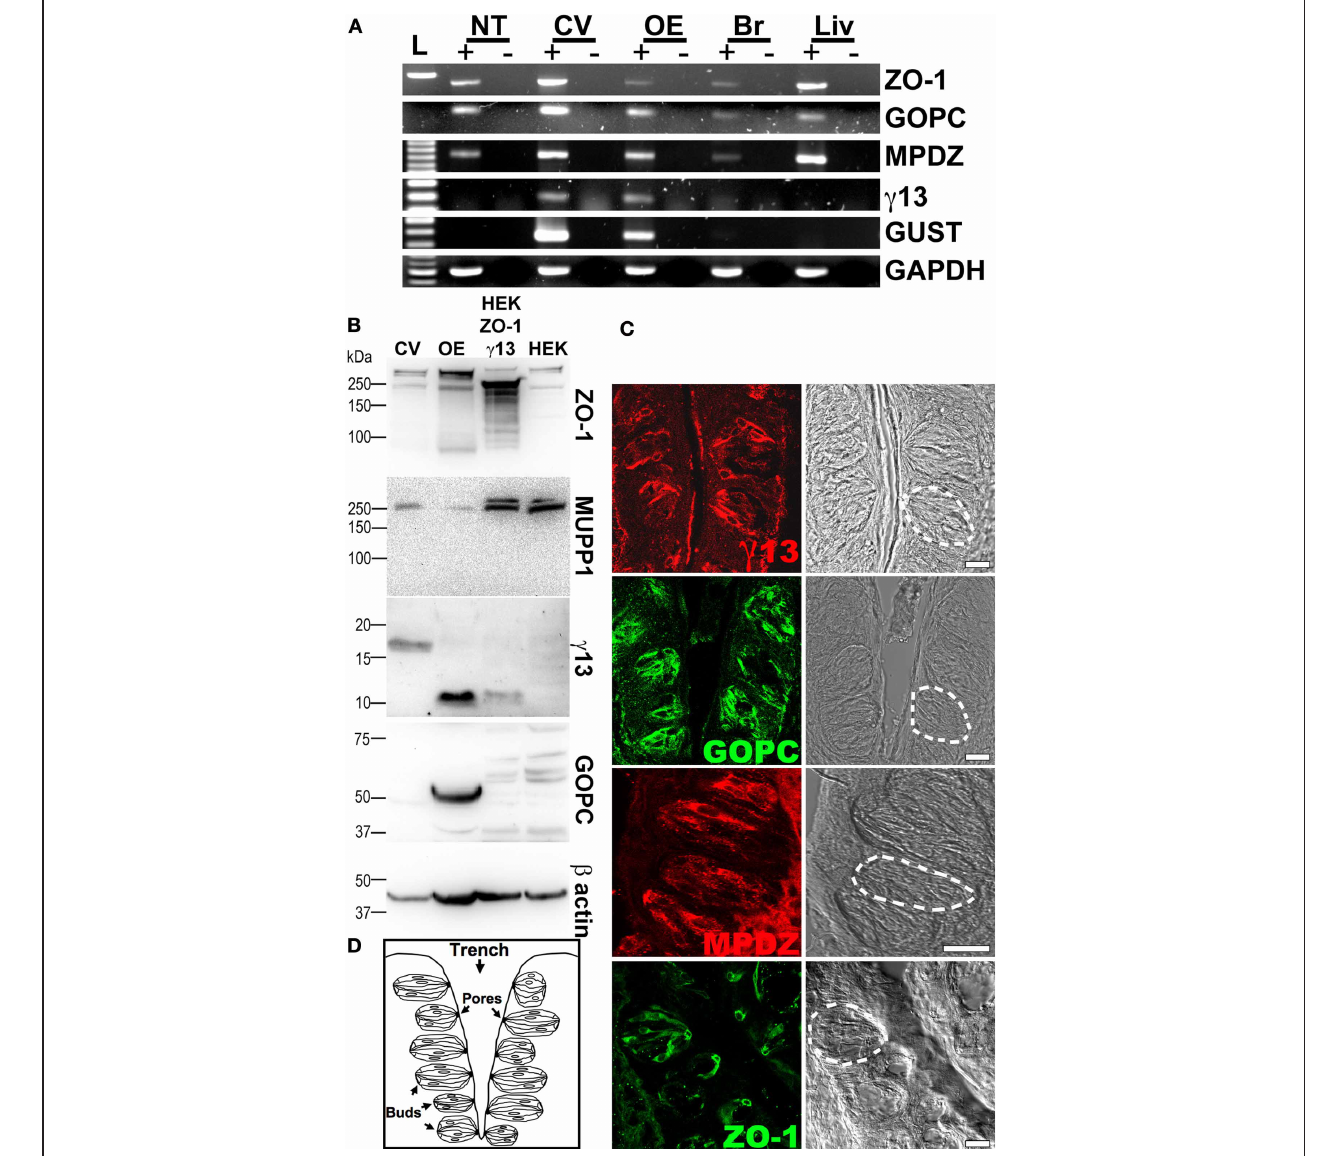
FIGURE 2 | Expression of GOPC, MPDZ, ZO-1 and G γ 13 in circumvallate papillae. (A) RT-PCR experiment demonstrating expression of ZO-1, GOPC, and MPDZ in all tissues tested. In contrast, the presence of G γ 13 and G α gust (GUST) mRNAs appear to be restricted to taste and olfactory sensory tissues. See Section “RT-PCR” and Table A1 for details about amplification conditions and expected sizes of PCR products. GAPDH primers were used as a control of the quality of the RNA. ( + ) and ( − ) indicate the presence or absence of reverse transcriptase in the reaction respectively. L: 100bp ladder. NT, tongue epithelium deprived of taste buds; CV, circumvallate papillae; OE, olfactory epithelium; Br, whole brain; Liv, liver. The results presented are representative of three independent experiments. (B) Immunodetection of ZO-1, MPDZ, GOPC, and G γ 13 proteins in circumvallate (CV) and whole olfactory epithelium (OE) protein extracts. Sample preparation and immunodetection conditions following western blotting are as described in detail under Section “Co-immunoprecipitation and Western blotting.” Protein extracts from HEK 293 cells (HEK) or HEK 293 cells stably expressing HA-G γ 13 transiently transfected with a full length Myc-ZO-1 construct (HEK ZO-1 γ 13) were used as controls. As expected ZO-1 and G γ 13 are detected in CV and OE. Note that G γ 13 displays a higher apparent